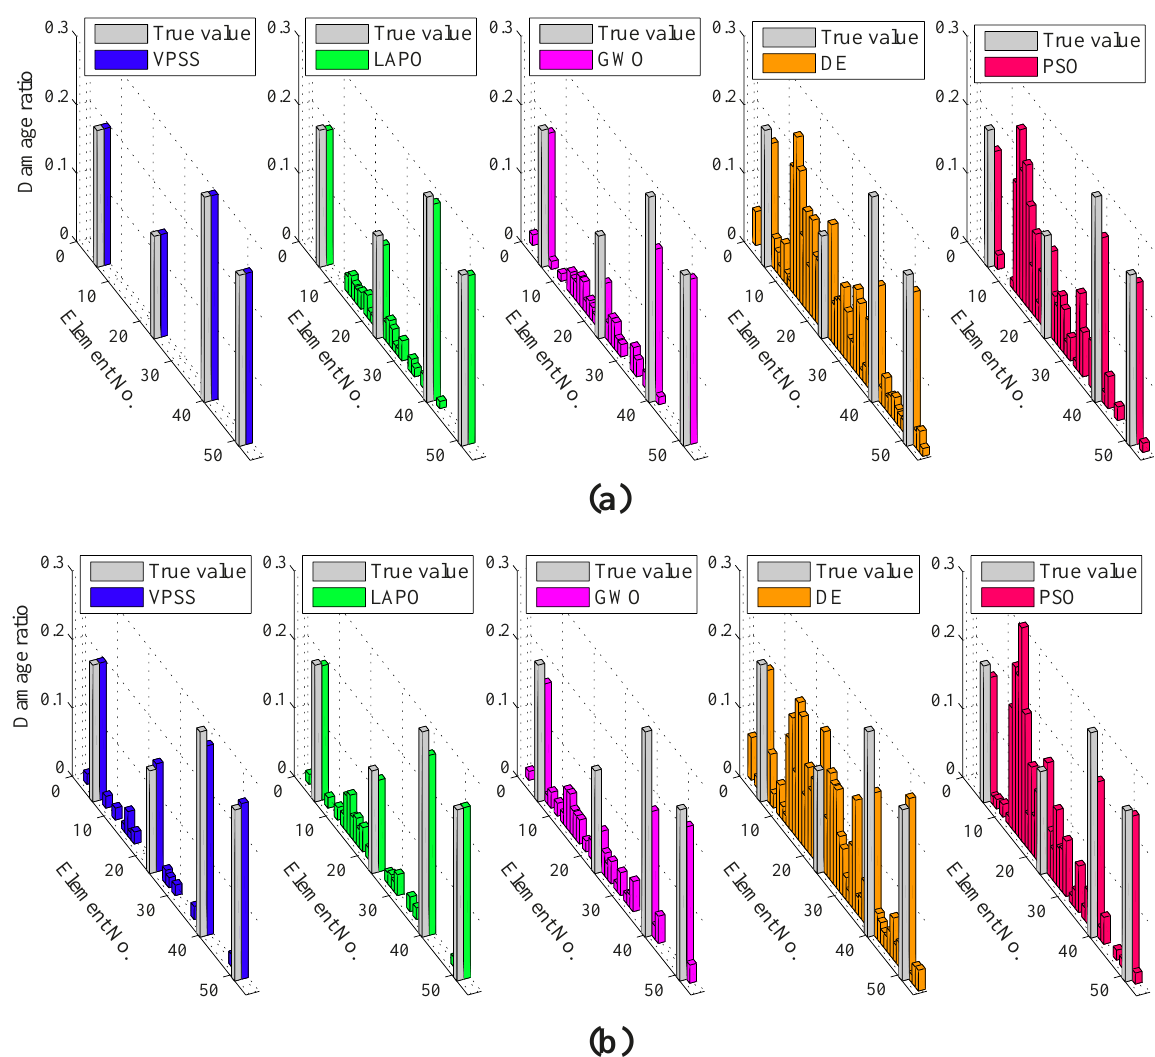
Figure 9. Damage identification results for the 54-bar space truss under the ( a ) noise-free condition and ( b ) noisy condition. Table 4. Statistical results of the damage identification for the 54-bar space truss.